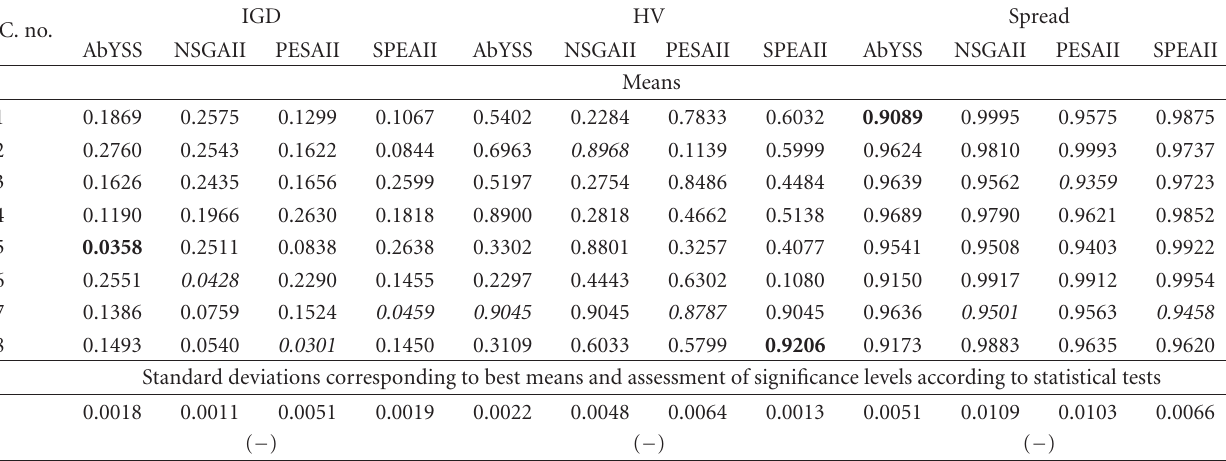
Table 2: Values of measurement quantities obtained by “Eval. Number = 1,000” and “Pop. Size = 50” for design example 1. C.